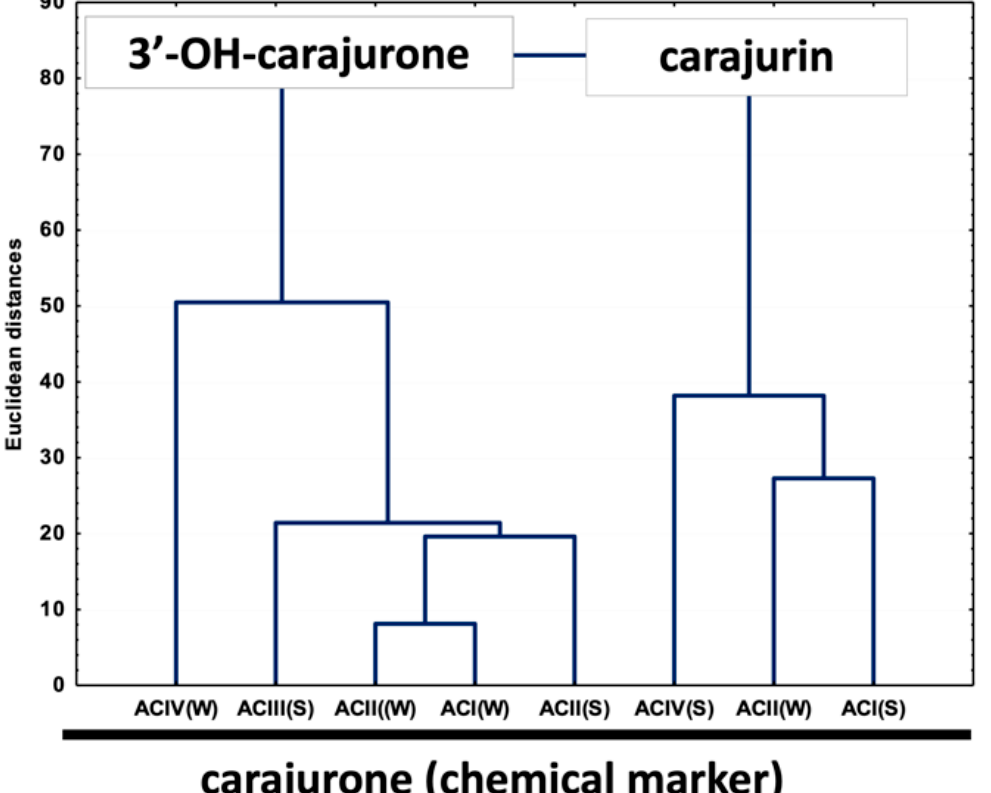
Figure 4. Unweighted air-group method with arithmetic average (UPGMA) dendrogram showing the similarity of chemical composition in anthocyanidins among eight extracts of Arrabidaea chica Verlot. 3 ′ -OH-carajurone = 3 ′ -hydroxy-carajurone.